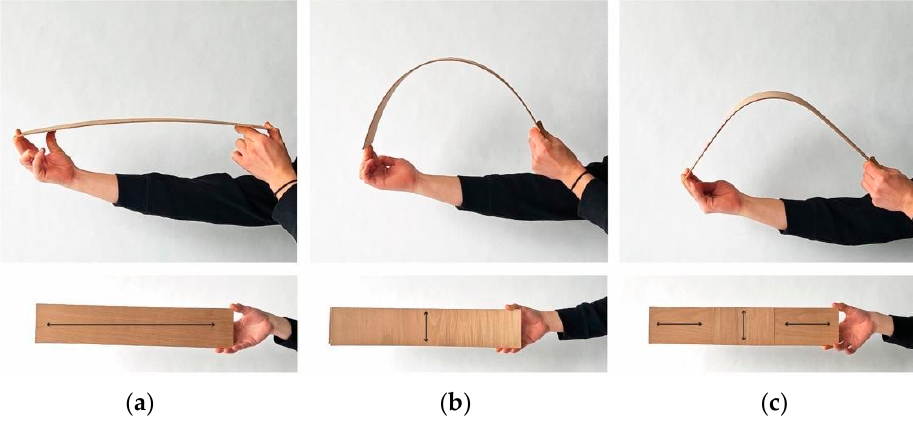
Figure 8. Bending studies with custom laminated grain directions: ( a ) 0 degrees with 0-degree bilayer; ( b ) 0 degrees with 90-degree bilayer; ( c ) mixed, 0 degrees with 0–90–0-degree bilayer.